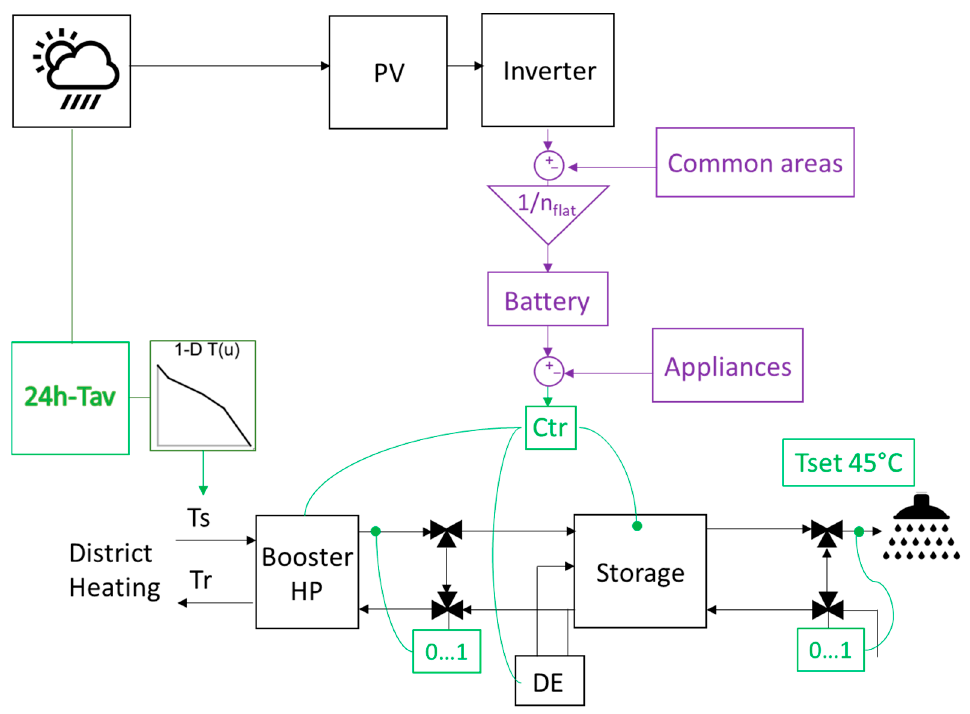
Figure 9. Simplified scheme of the developed simulation model of the booster HP including PV, battery and control.